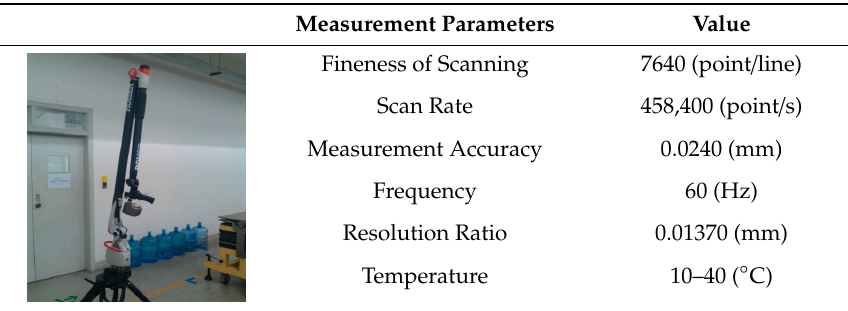
Table 1. Measurement parameters.